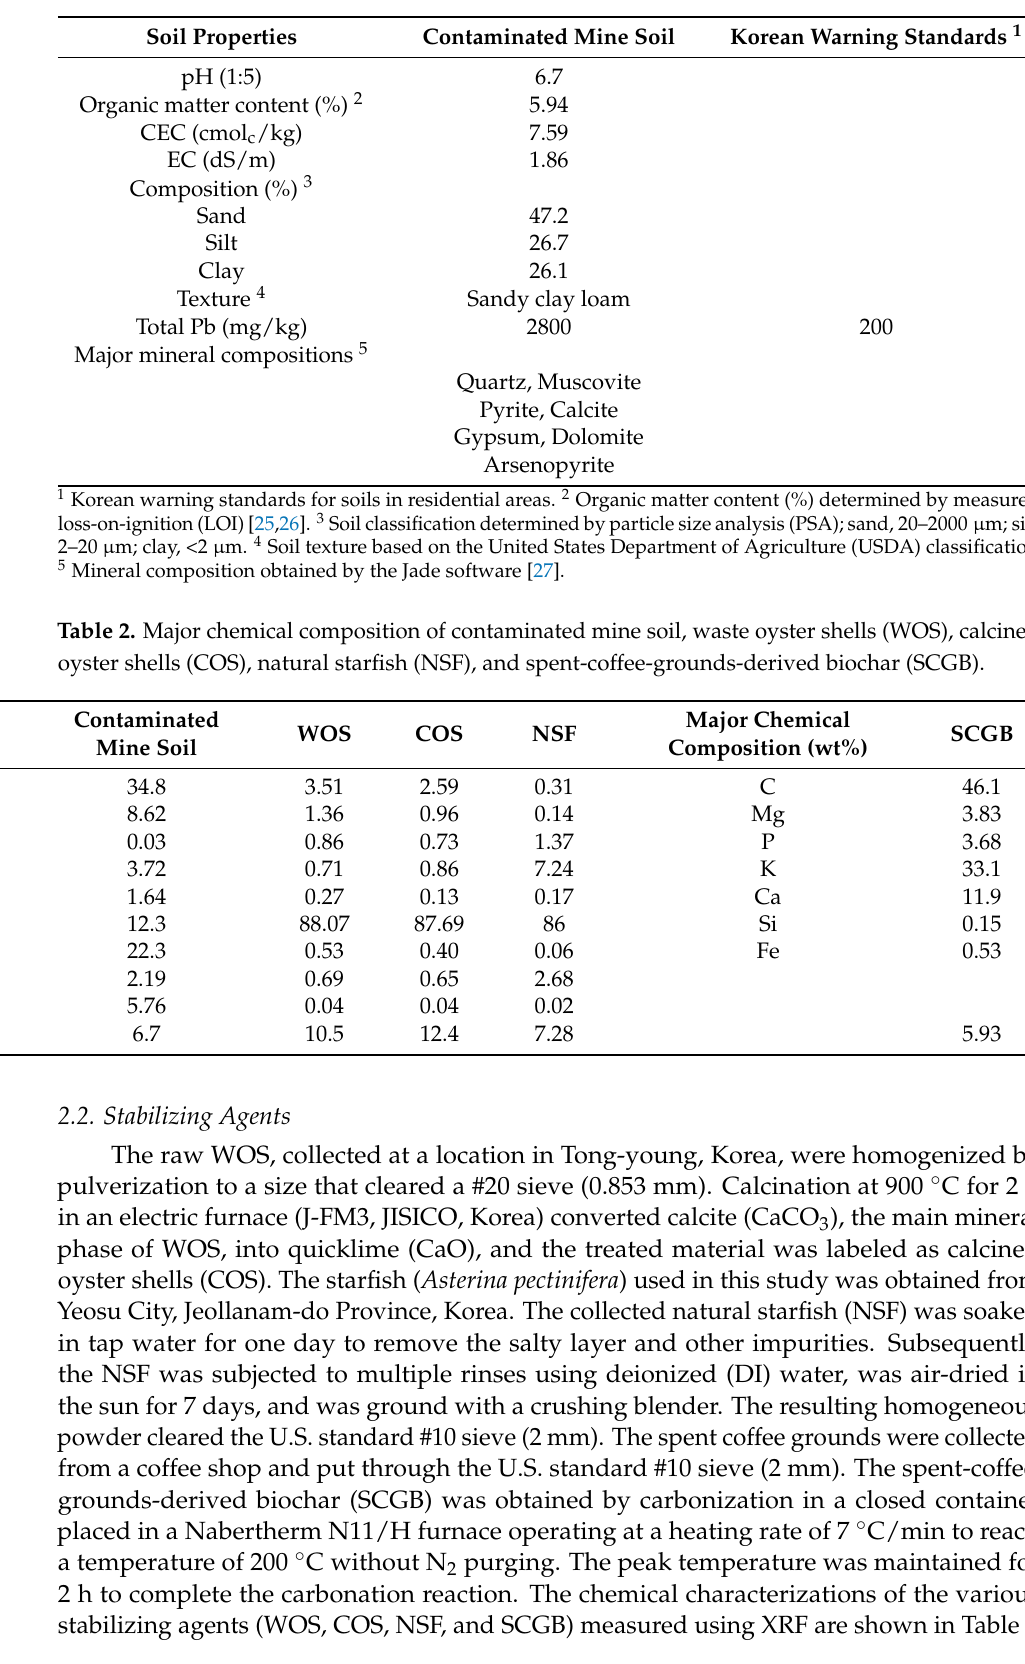
Table 1. Characterization of the Pb-contaminated mine soil.